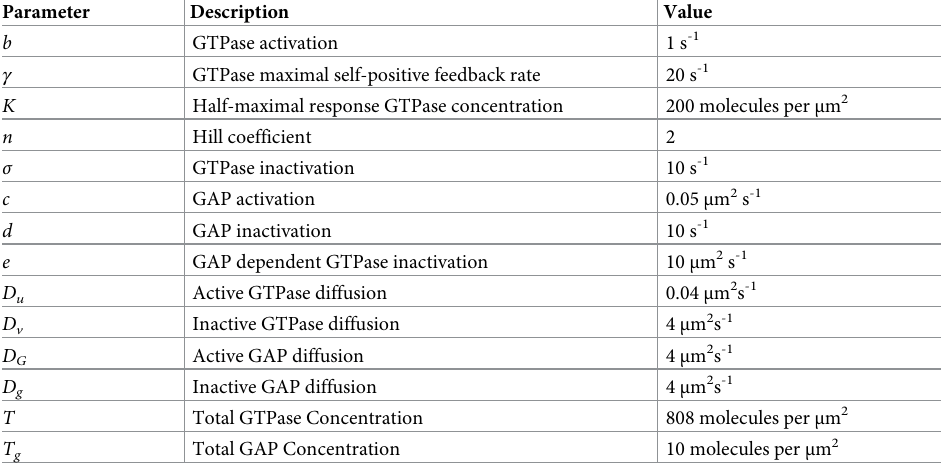
Table 1. Baseline parameter